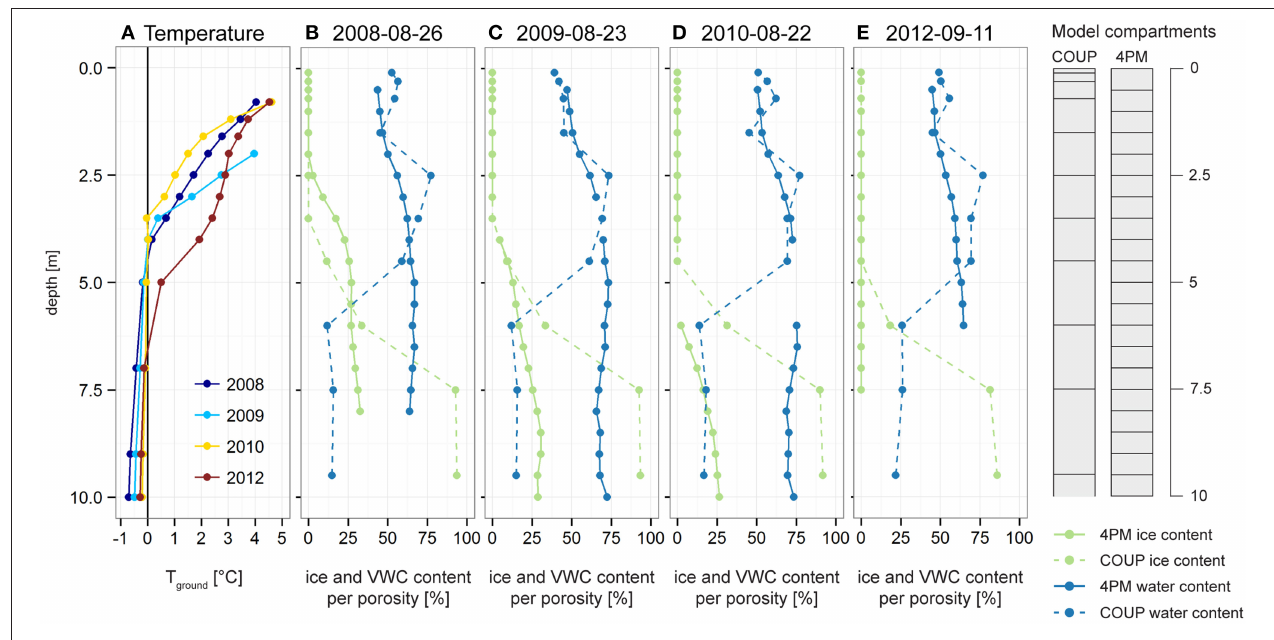
FIGURE 11 | Vertical distribution of borehole temperatures (A), water (blue lines) and ice (green lines) content per porosity modeled by the COUP model (dashed lines) and the 4PM model (solid lines) at Schilthorn (B–E). The COUP and 4PM model compartments are displayed on the